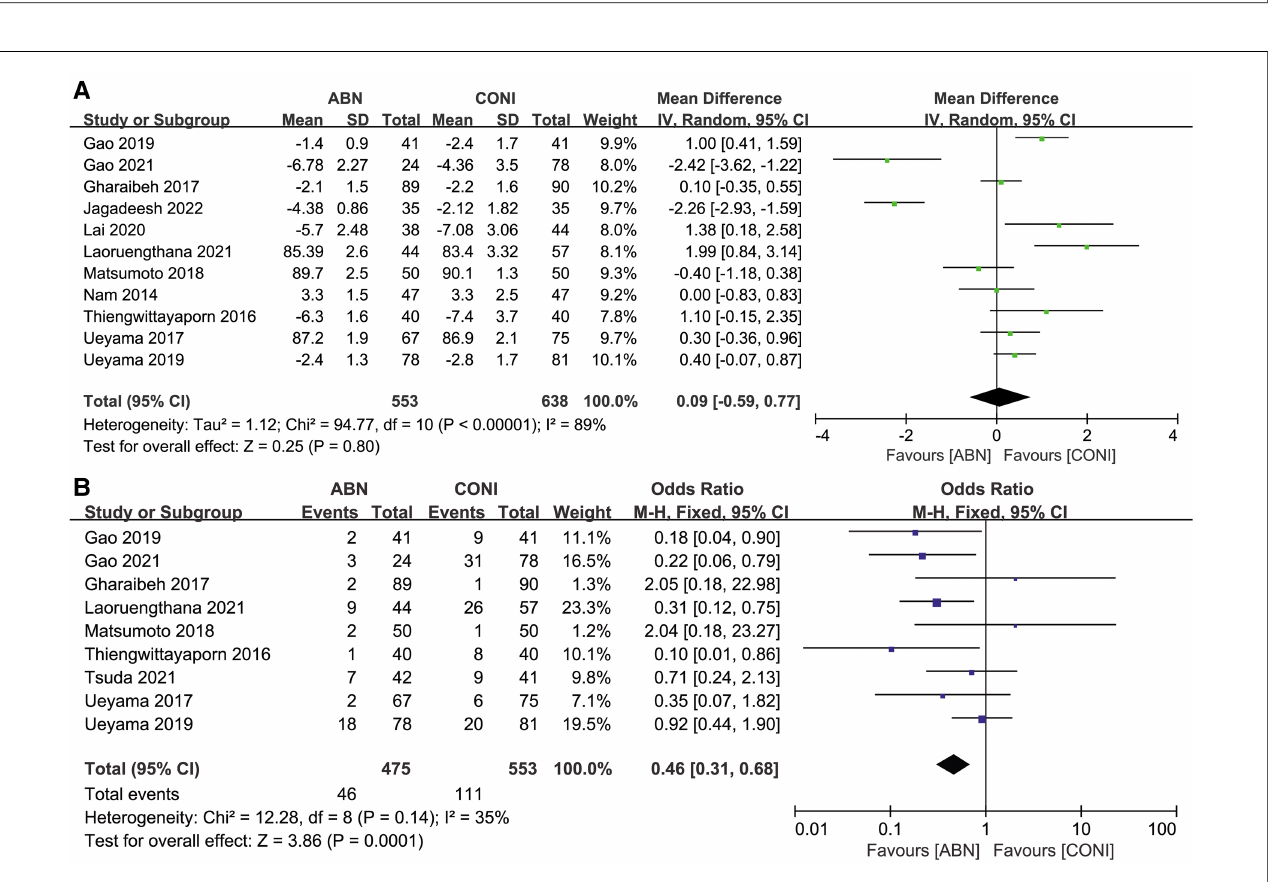
FIGURE 9 Forest plot of sagittal femoral angle(SFA). ( A ) And SFA outliers( B ) between accelerometer-based navigation (ABN) system and conventional instrumentation (CONI).